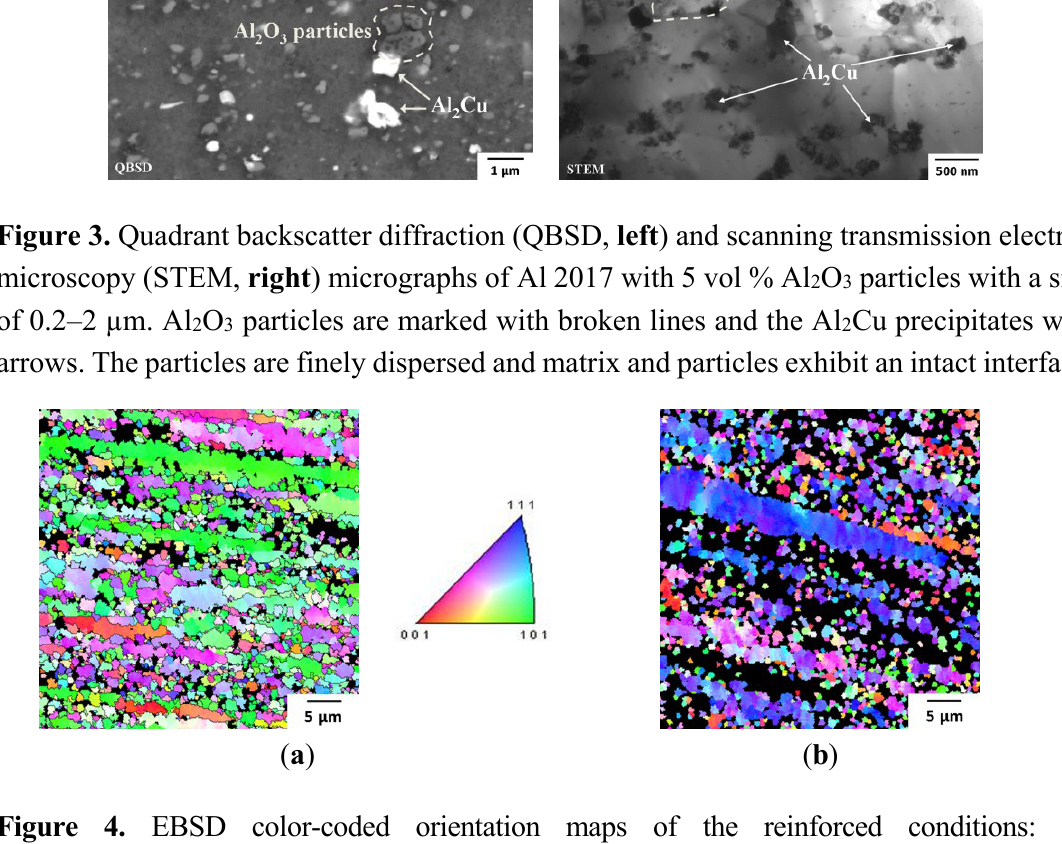
Figure 4. EBSD color-coded orientation maps of the reinforced conditions: ( a ) non-ECAP-processed and ( b ) after additional ECAP. For the reinforced material, ECAP does not lead to a significant grain